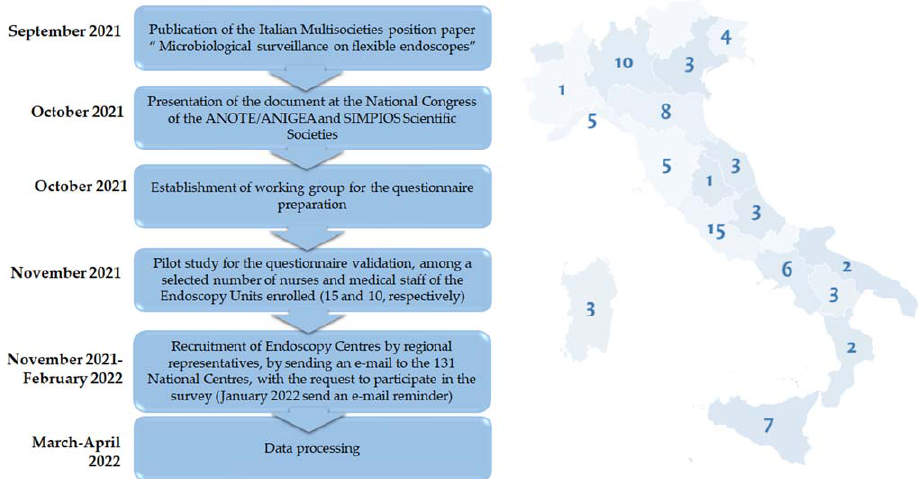
Figure 1. Timeline of the study design and geographical distribution of respondent centers per region.